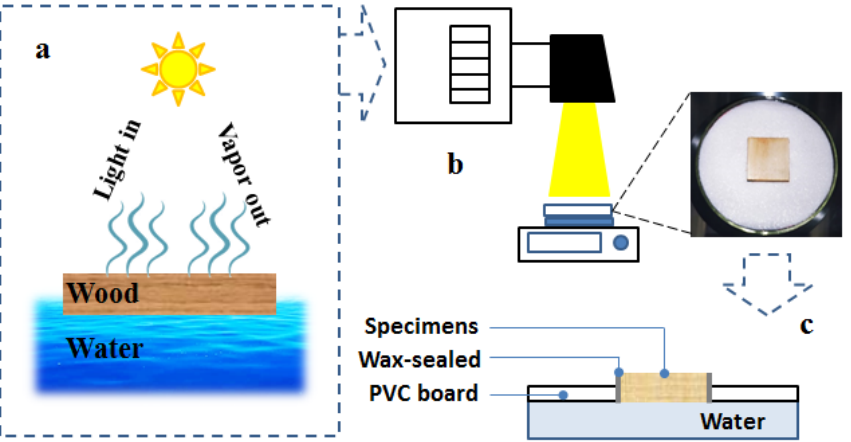
Figure 2. The schematic of the photothermal transpiration test. ( a ) Experimental design of a wooden solar evaporator; ( b ) test method diagram; ( c ) PVC (5 mm thickness) was made into a circular board of 90 mm diameter to match the diameter of the Petri dish. A square hole of the same size as the test piece was cut at the center of the PVC plate. The test piece was inserted into the square hole of the PVC circular board, and the lower surface of the test piece was flush with the lower surface of the PVC. The assembled PVC circular board floated on a Petri dish filled with pure water such that the surface of the test piece was in contact with the